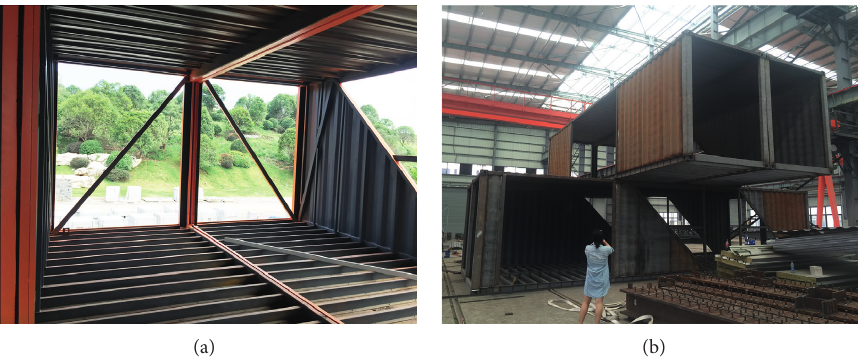
Figure 11: Photos of construction site. (a) Site installation of structurally strengthened modules. (b) Factory manufacturing and trial assembly of container building modules.